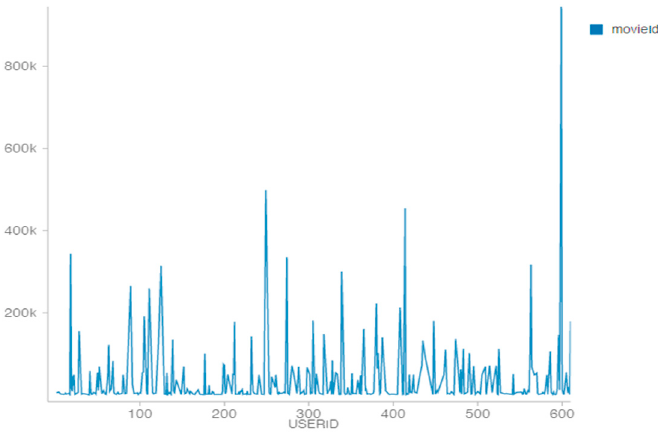
Figure 9. The area covered by the results after predicting the ratings. Table 5. The number of iterations with regularization with different RMSE parameter